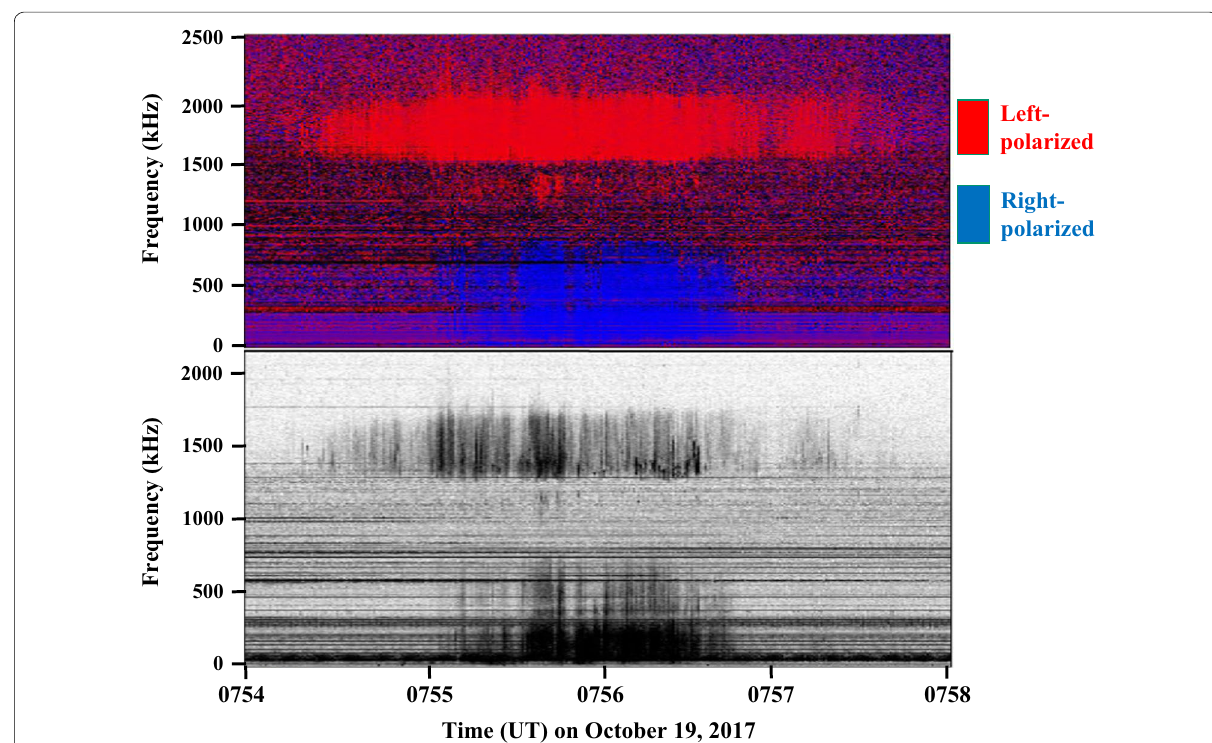
Fig. 2 Spectrograms of intensity (bottom panel) and polarization (top panel) of MFB emission observed at Toolik Lake on October 19, 2017, showing that the component of MFB below 1.5 MHz is left-polarized, like the bulk of the MFB emission, and unlike the right-polarized whistler mode auroral hiss